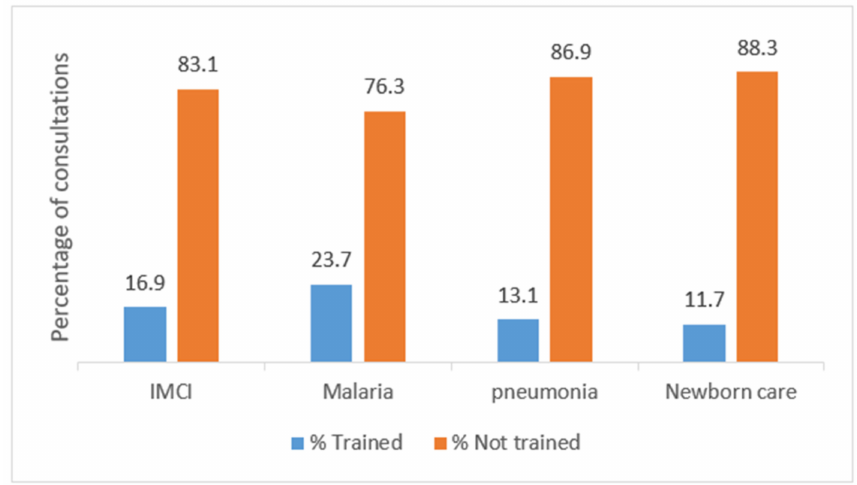
Figure 2. Percentage of consultations in low-level private health facilities in Mbarara, carried out by healthcare workers who had or not received refresher training in management of common childhood infections in the past 6